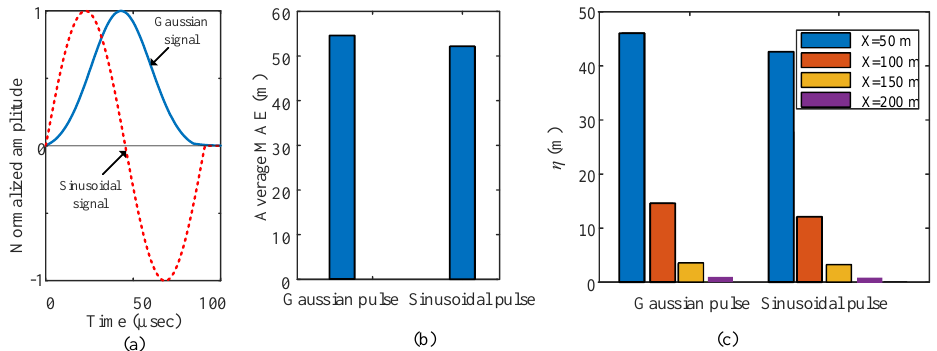
Figure 7. Sensing signal type effect on the system performance: ( a ) Sensing signal type, ( b ) average MAE, and ( c ) value of η for different values of X